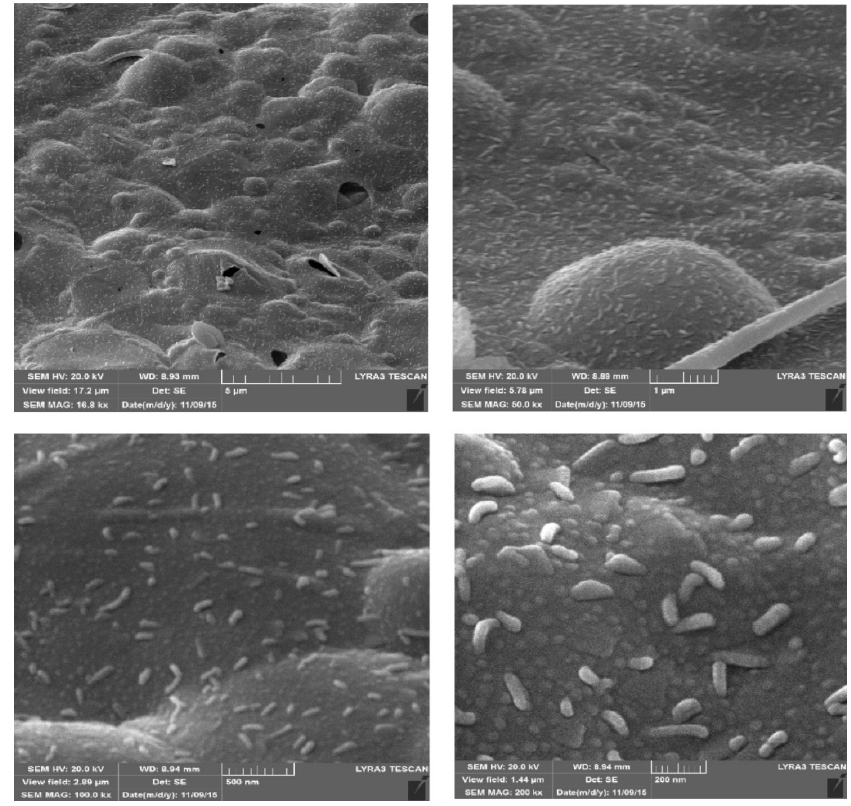
Figure 3. SEM images at different magnifications showing the distribution of ZnO nanoparticles over the surface of carbon foam. Source: Reproduced from [12], with permission from Elsevier .